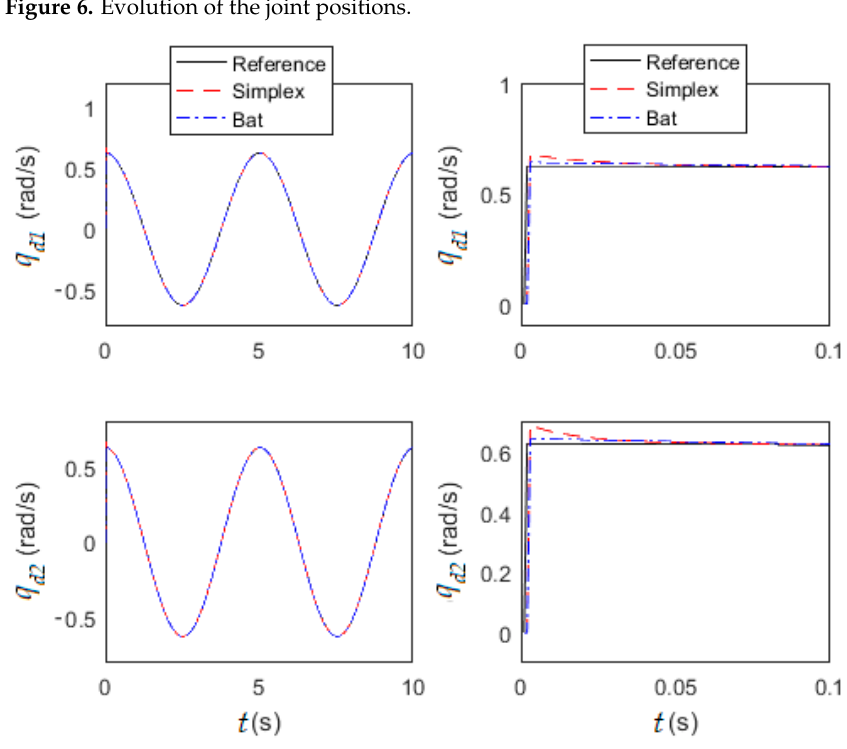
Figure 7. Evolution of the joint velocities.